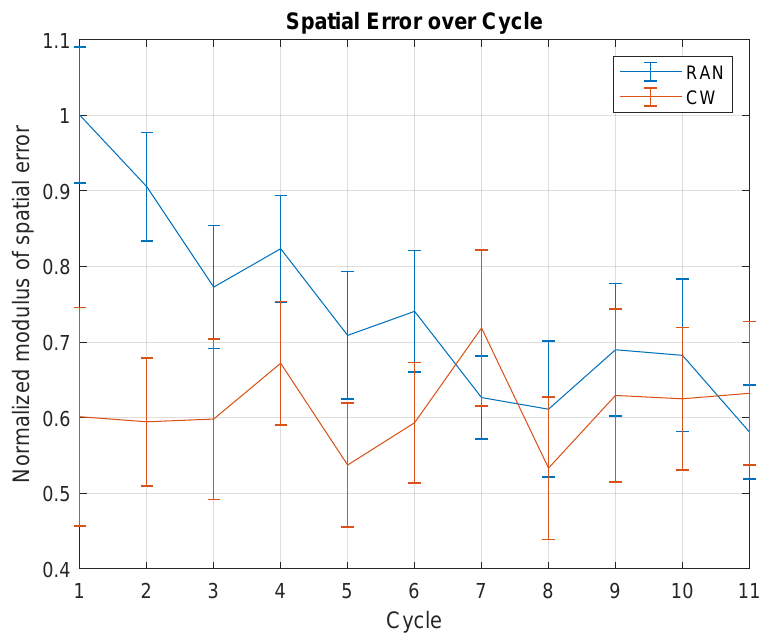
Figure 7. Normalised modulus of spatial error (SpTE), over cycles, for RAN (blue) and CW (red) modes. The normalisation was based on the mean SpTE obtained in the first cycle of the RAN section.